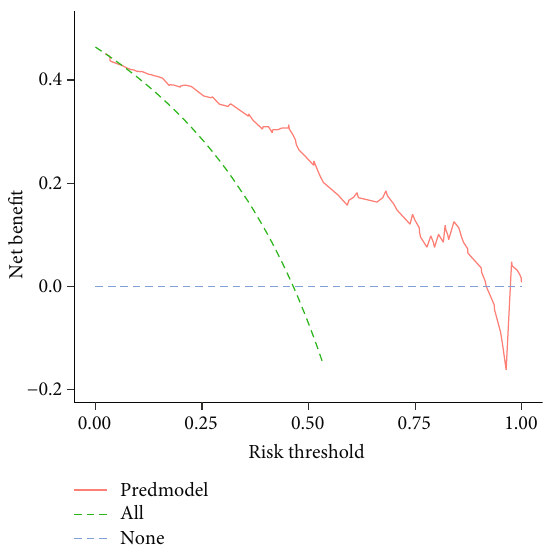
Figure 5: Decision curve analysis for the amputation risk nomogram. The y -axis measured the net bene fi t. The green dotted line represented the assumption that all patients had amputation. The blue dotted line represented the assumption that all patients had no amputation. The red solid line represented the risk